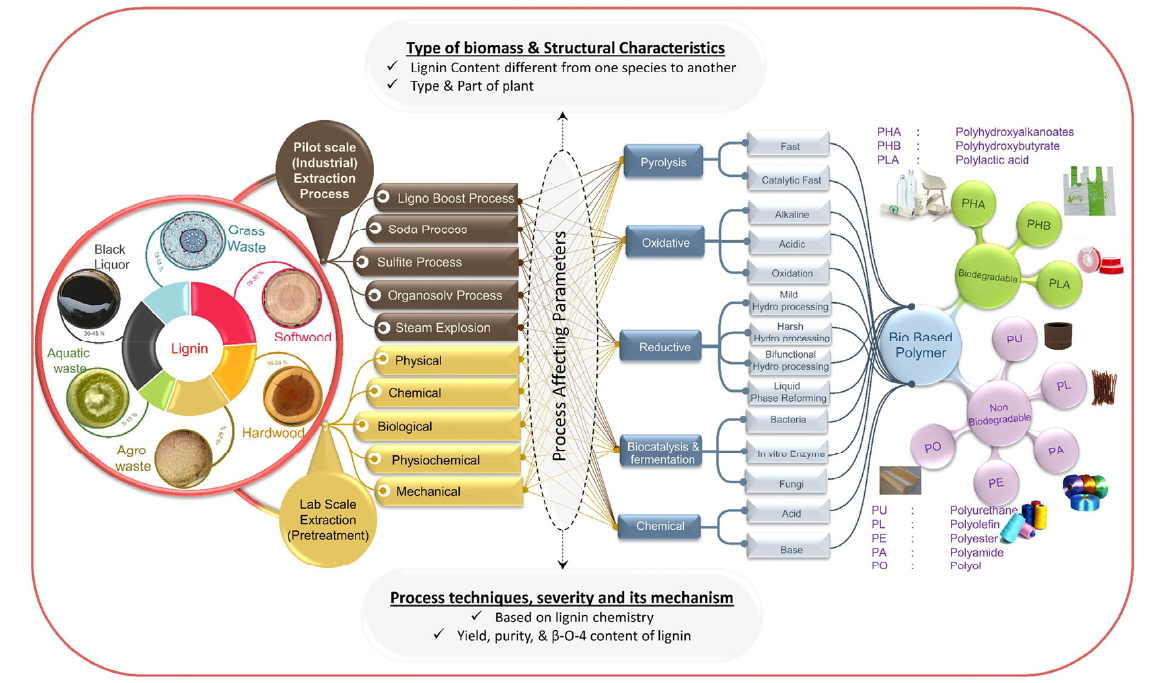
Figure 3. Schematic representation of lignin valorization on biopolymer production. Reprinted with permission from [17]. Copyright 2019, Elsevier Ltd